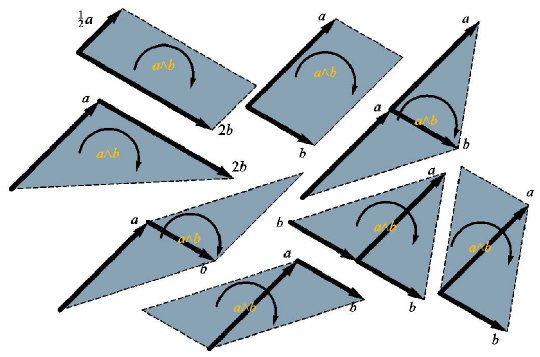
Figure 8: Different shapes for the same bivector, a ∧ b .